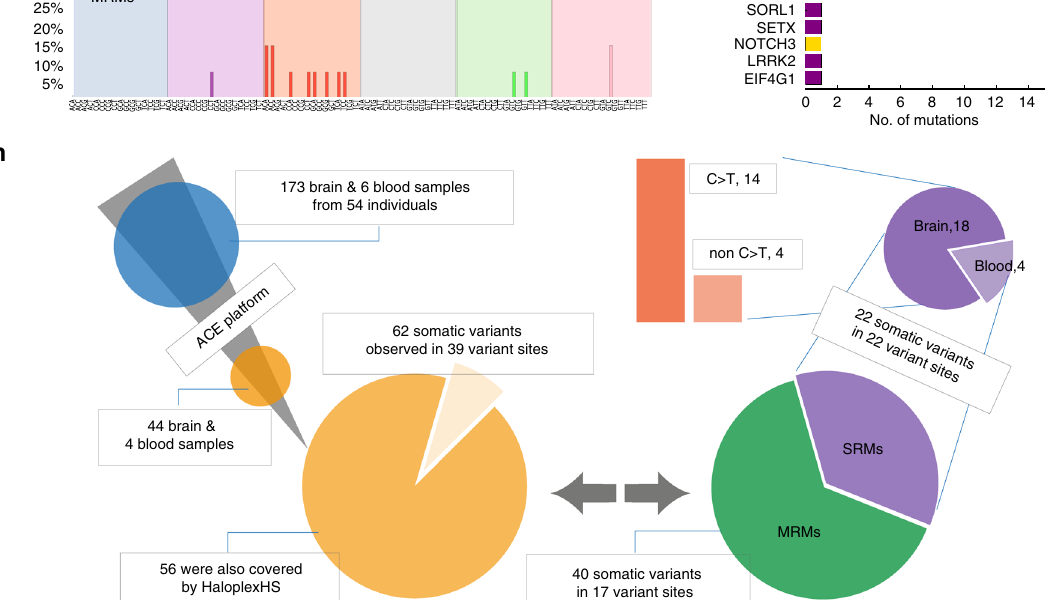
5%. DNA from cell-line NA12878 was spiked into DNA from cell-line NA12877 by using 2, 5, 10, 20 or 50 ng of NA12878, making up to 1µg total DNA with NA12877 thus achieving the stated simulated VAFs. High con fi dence, pedigree consistent germline variants, concordantly called on several platforms from high- depth after PCR-Free sample preparation were obtained for each sample from